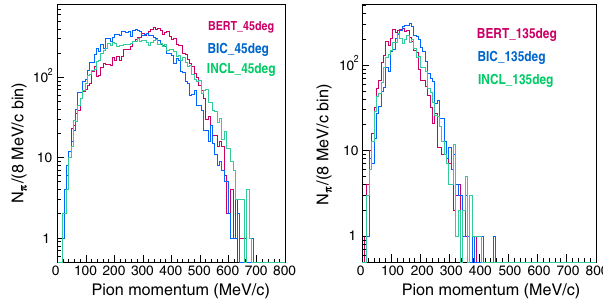
FIG. 4. Pion momentum spectra predicted by three hadronic models, Bertini, Binary, and INCL-ABLA. Detectors are placed diagonally opposed at 45 and 135 degrees with respect to the proton